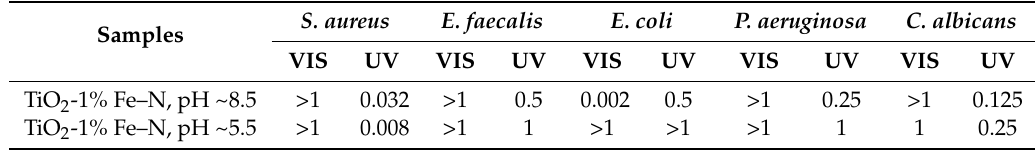
Table 7. The MBEC (mg · mL − 1 ) values of the TiO 2 -1% Fe–N nanoparticles against the tested microbial